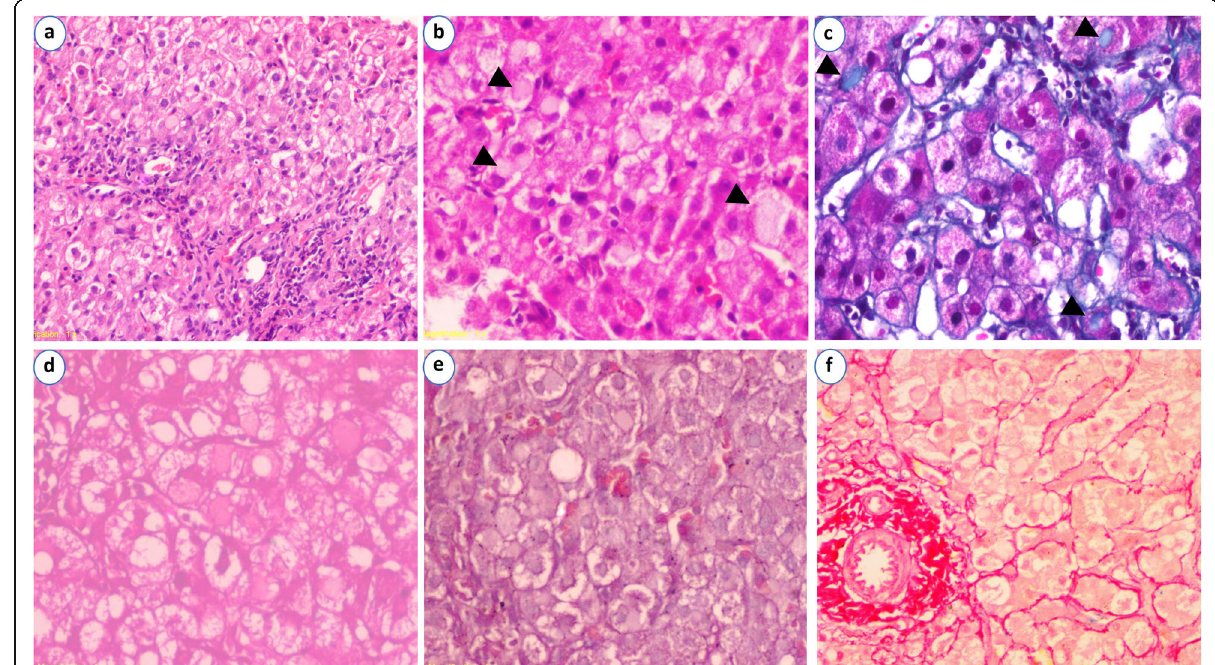
Fig. 1 Histopathology of COVID-19-induced hepatitis. a Mild expansion of portal tracts by chronic inflammatory cells with mild interface hepatitis and mild periportal fibrosis (H&E × 100). b Higher power showing numerous pale intracytoplasmic eosinophilic globules (H&E × 400). c The globules were highlighted by trichrome stain as light blue globules (MT × 400). d The globules faded after staining with periodic acid-Schiff- diastase stain (PAS-D × 400). e Lack of copper associated globules within hepatocytes and negative staining of the globules (Orcein × 400). f Lack of iron deposition within hepatocytes and negative staining for the globules (Perls Prussian blue ×